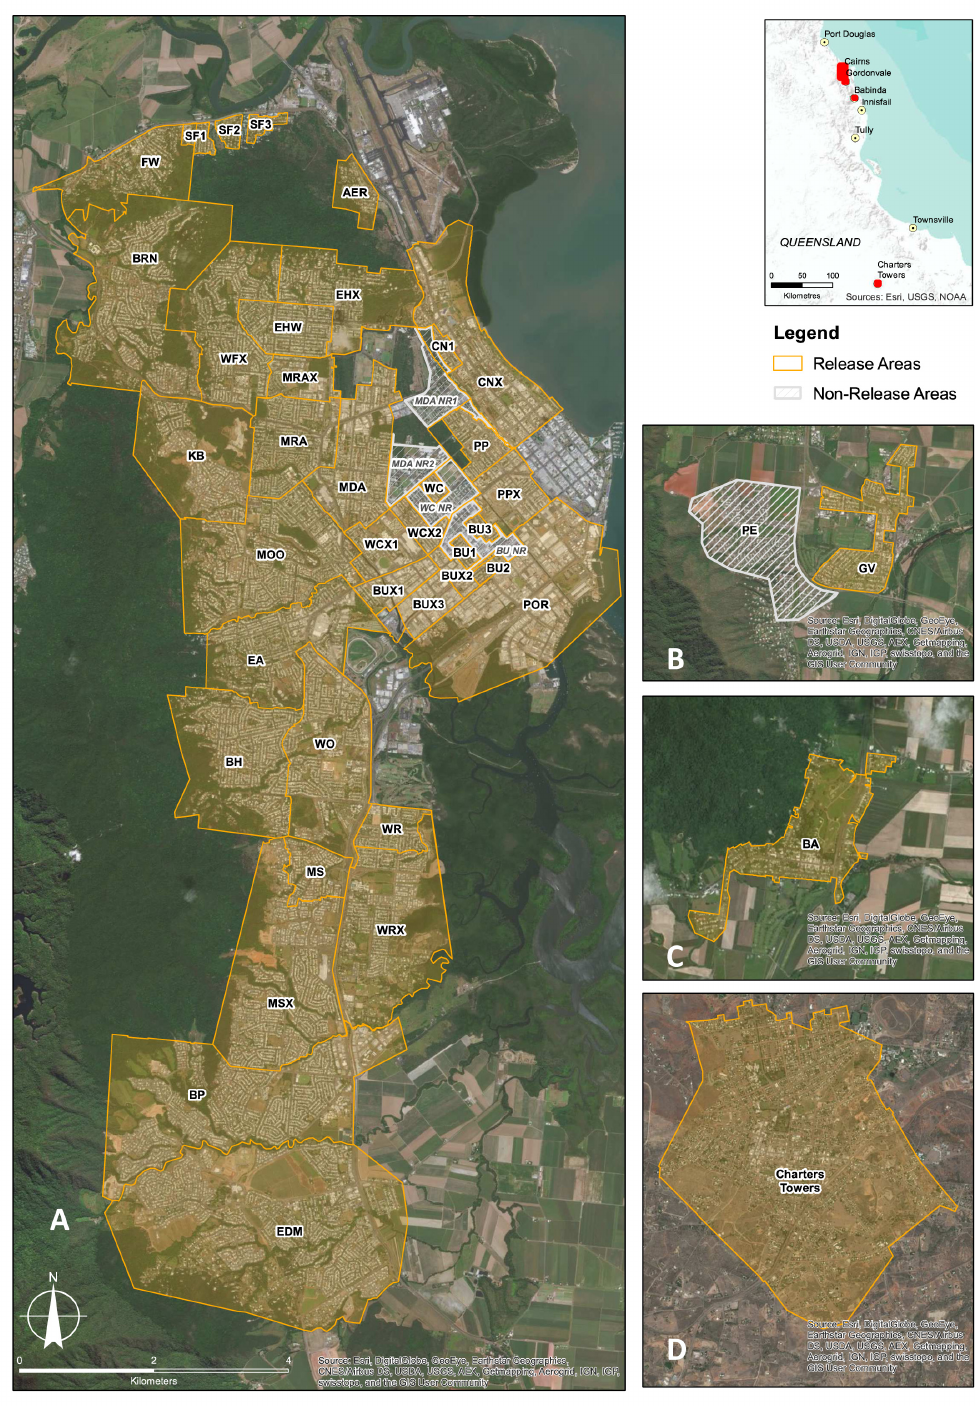
Figure 2. Map of Cairns (central) release areas and non-release areas. Aeroglen (AER), Bayview Heights (BH), Bentley Park (BP), Brinsmead (BRN), Bungalow 1 (BU1), Bungalow 2 (BU2), Bungalow 3 (BU3), Bungalow Ext 1 (BUX1), Bungalow Ext 2 (BUX2), Bungalow Ext 3 (BUX3), Bungalow non-release area (BU NR), Cairns North 1 (CN1), Cairns North Ext (CNX), Earlville (EA), Edge Hill Ext (EHX), Edge Hill/Whitfield (EHW), Edmonton (EDM), Freshwater (FW), Kanimbla (KB), Manoora (MRA), Manoora Ext (MRAX), Manunda (MDA), Manunda non-release area 1 (MDA NR1), Manunda non-release area 2 (MDA NR2), Mooroobool (MOO), Mount Sheridan (MS), Mount Sheridan Ext (MSX), Parramatta Park (PP), Parramatta Park Ext (PPX), Portsmith (POR), Stratford 1 (SF1), Stratford 2 (SF2), Stratford 3 (SF3), Westcourt (WC), Westcourt non-release area (WC NR), Westcourt Ext 1 (WCX1), Westcourt Ext 2 (WCX2), White Rock (WR), White Rock Ext (WRX), Whitfield Ext (WFX), Woree (WO) ( A ), Gordonvale (GV) release area and Pyramid Estate non-release area (PE) ( B ); Babinda (BA) release area ( C ), and Charters Towers (CT) release area ( D